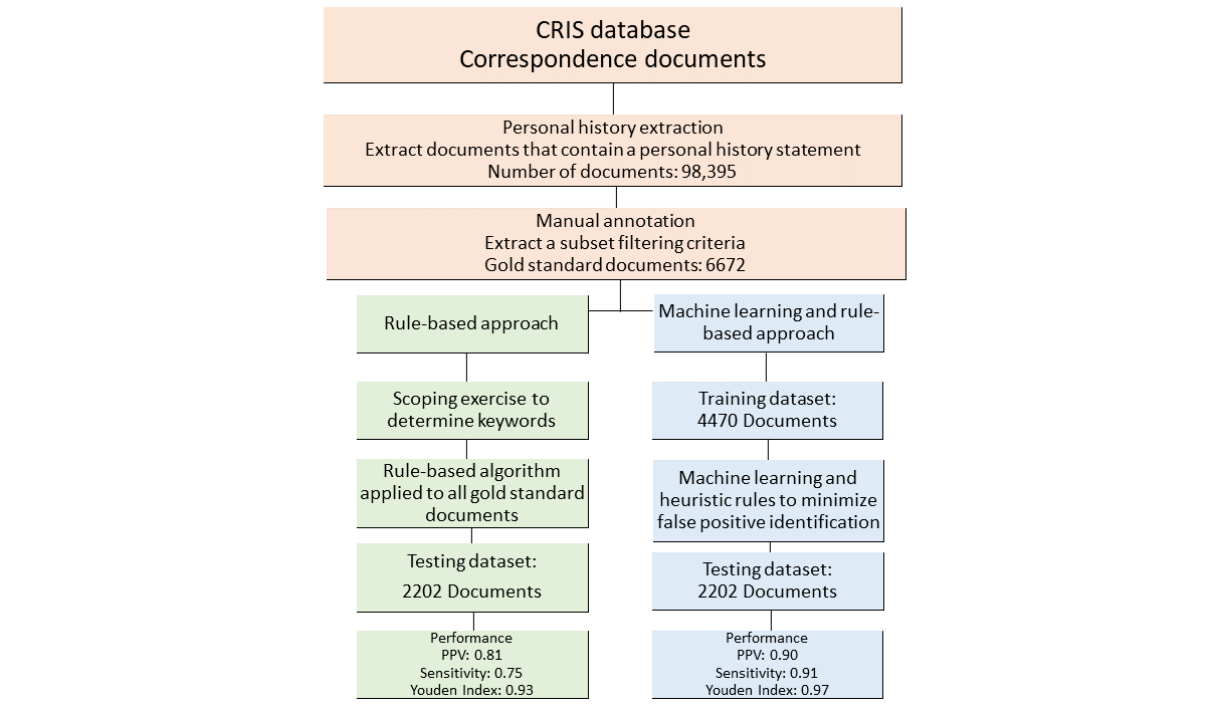
Figure 1. Flow diagram of the Military Service Identification Tool. Correspondences are used to define any communications between a patient and